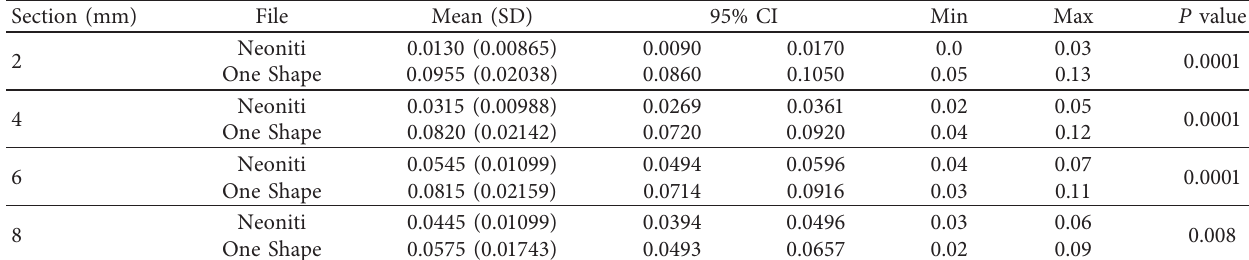
Table 2: Amount of canal